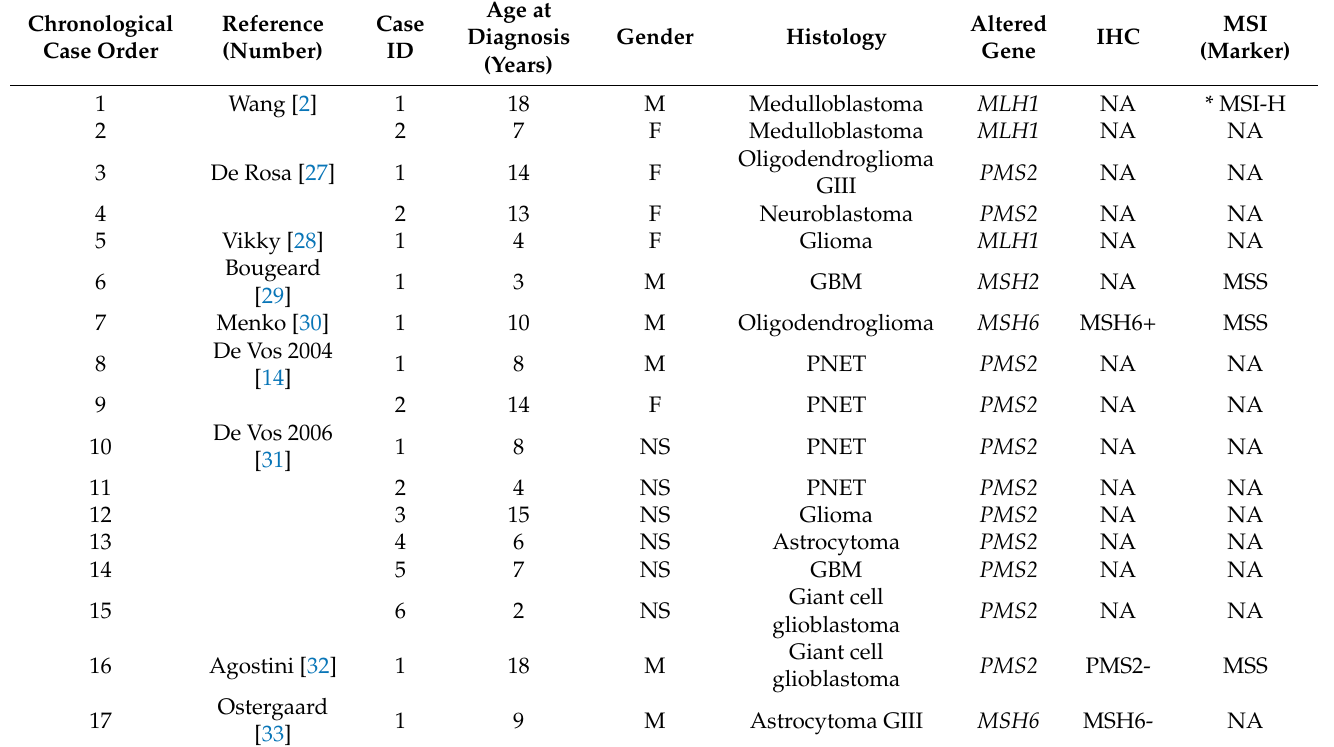
Table 4. Clinicopathological and molecular features of brain tumors in CMMRD